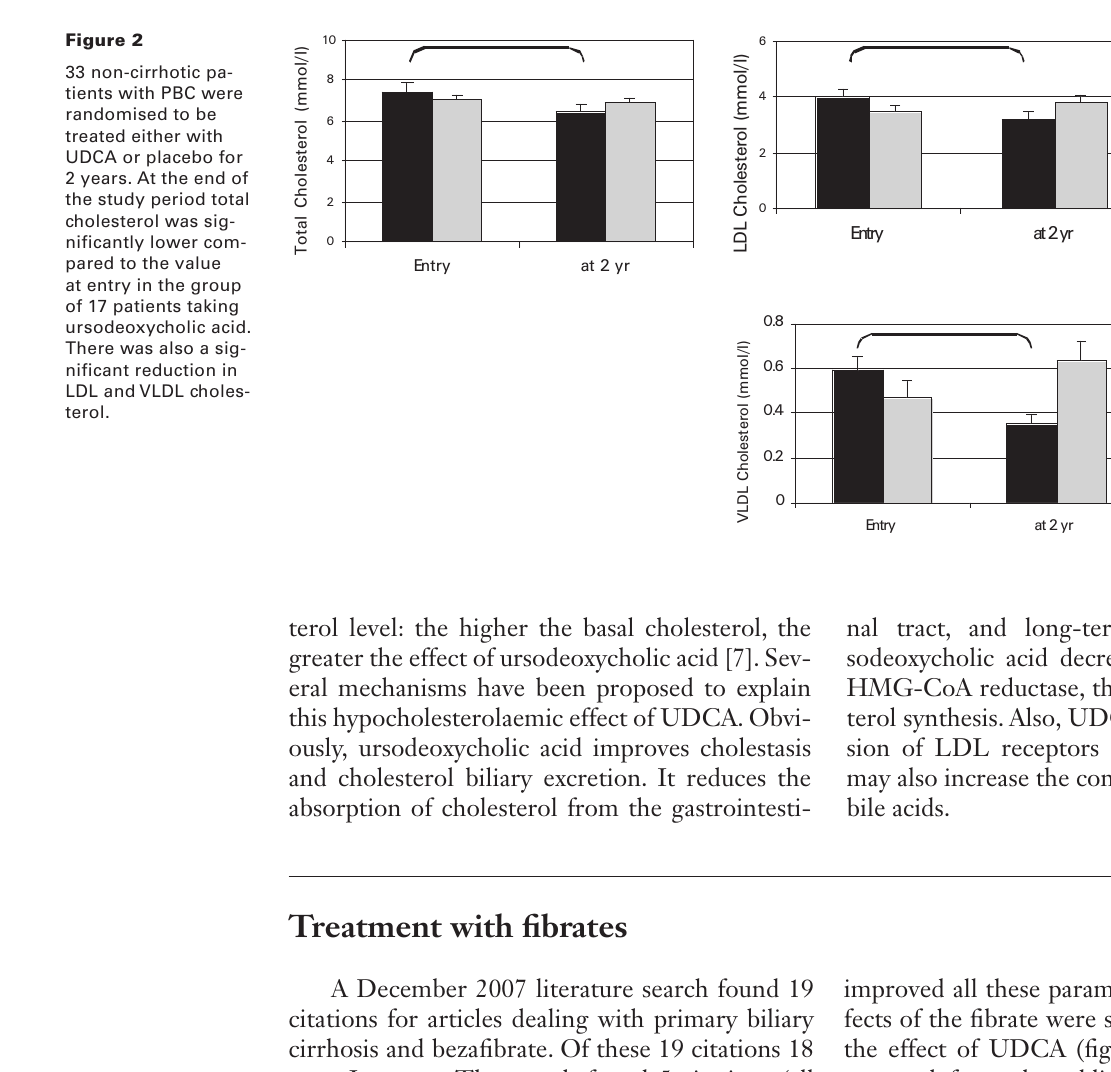
24 patients were randomised to re- ceive either bezafi- brate 200 mg twice daily or UDCA 600 mg/day. Not surpris- ingly, treatment with UDCA significantly improved ALT, alka- line phosphatase and the g -GT levels (grey lines). There were very modest effects on the total IgM con- centration. Bezafi- brate improved all these parameters as well (black lines) and the effects of the fi- brate were signifi- cantly greater than the effect of UDCA (adapted from